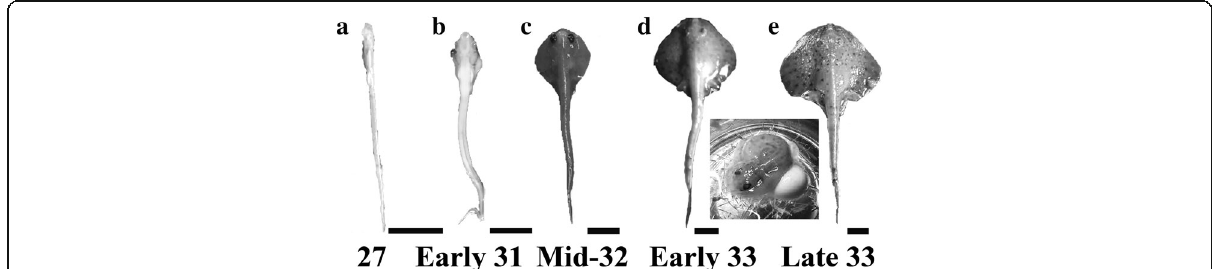
Fig. 2 Whole mount images of Leucoraja erinacea at ( a ) stage 27, ( b ) early stage 31, ( c ) mid-stage 32, ( d ) early stage 33 and ( e ) late stage 33. Inset shows early stage 33 embryo with yolk. Scale bars equal 1